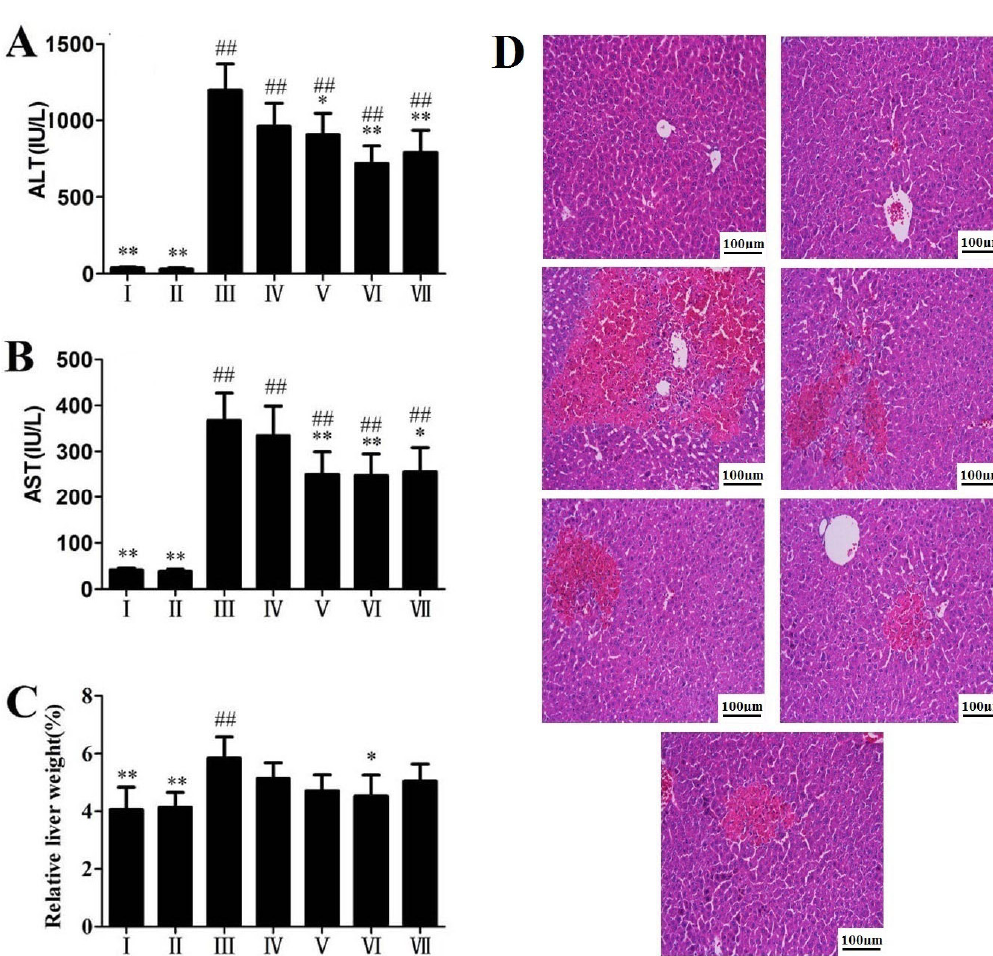
Figure 1. Effects of RLTS on serum ALT and AST activities ( A and B ), relative liver weight ( C ) and histopathological examination by hematoxylin and eosin (H&E)